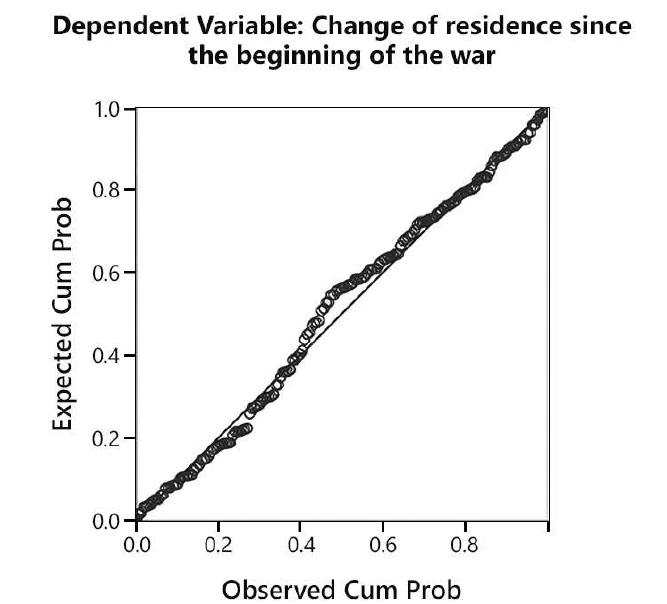
Figure 3. Normal P-P graph of standardized